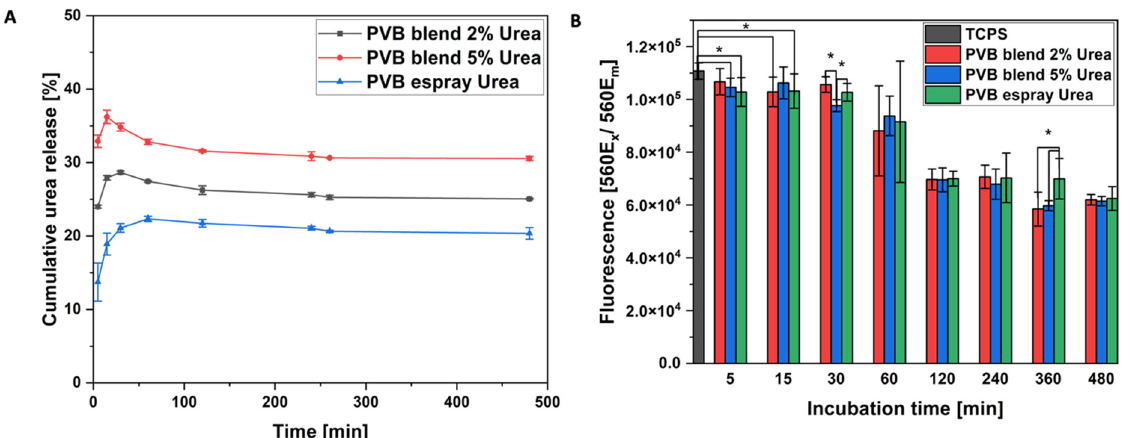
Figure 3. ( A ) Cumulative urea release from PVB fibers blended and electrosprayed with urea, ( B ) Biocompatibility test after 24 h of keratinocytes cultured with the medium incubated with PVB fibers blended and electrosprayed with urea for 5, 15, 30, 60, 120, 240, 360, 480 min; TCPS was used as a positive control. * Statistical significance calculated with ANOVA, followed by Tukey’s post hoc test, p < 0.05; error bars are based on standard deviation. All the samples incubated for 30 min and more showed statistically significant difference with TCPS.